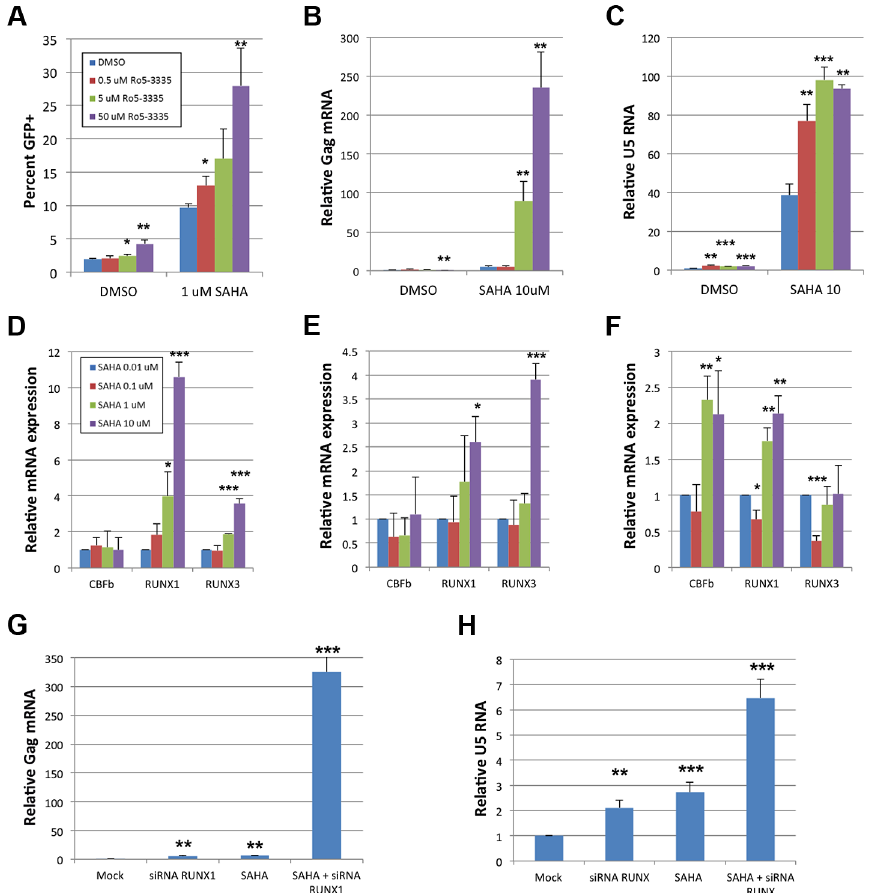
Figure 6. Ro5-3335 RUNX inhibitor synergizes with SAHA HDAC inhibitor. A ) JLat cells were cultured in the presence of increasing concentrations of Ro5-3335 in the presence or absence of 1 m M SAHA. Seventy-two hours after treatment the percentage of GFP positive cells was determined by flow cytometry. B ) ACH2 cells were cultured with Ro5-3335 and 10 m M SAHA as in panel A. Forty-eight hours post treatment RNA was extracted from the cells and used to determine the relative increase in HIV-1 Gag mRNA as normalized to GAPDH. C ) TZMbl cells were cultured with Ro5-3335 and 10 m M SAHA as above. Forty-eight hours post treatment RNA was extracted from the cells and used to determine the relative increase in HIV-1 U5 mRNA as normalized to GAPDH. D ) Jlat, E ) ACH2 and F ) TZMbl were cultured in the presence of the indicated concentrations of SAHA. Forty-eight hours post treatment RNA was extracted from the cells and used to determine the relative changes in RUNX1, CBF- b or RUNX3. G ) ACH2 or H ) TZMbl cells were transfected with 50 pMol siRNA against RUNX1 and/or treated with 10 m M SAHA at twenty-four hours post transfection. Forty- eight hours post transfection RNA was extracted and expression measured as above. * p # 0.05, ** p # 0.01 and *** p # 0.001